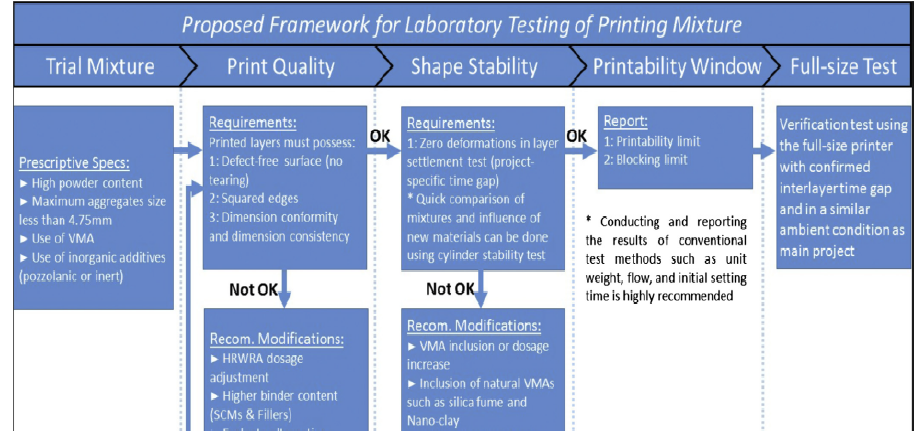
Figure 10. Proposed framework for performance testing of cementitious mixtures. Reprinted with permission from ref. [94]. Copyright 2018 Copyright Elsevier B.V.